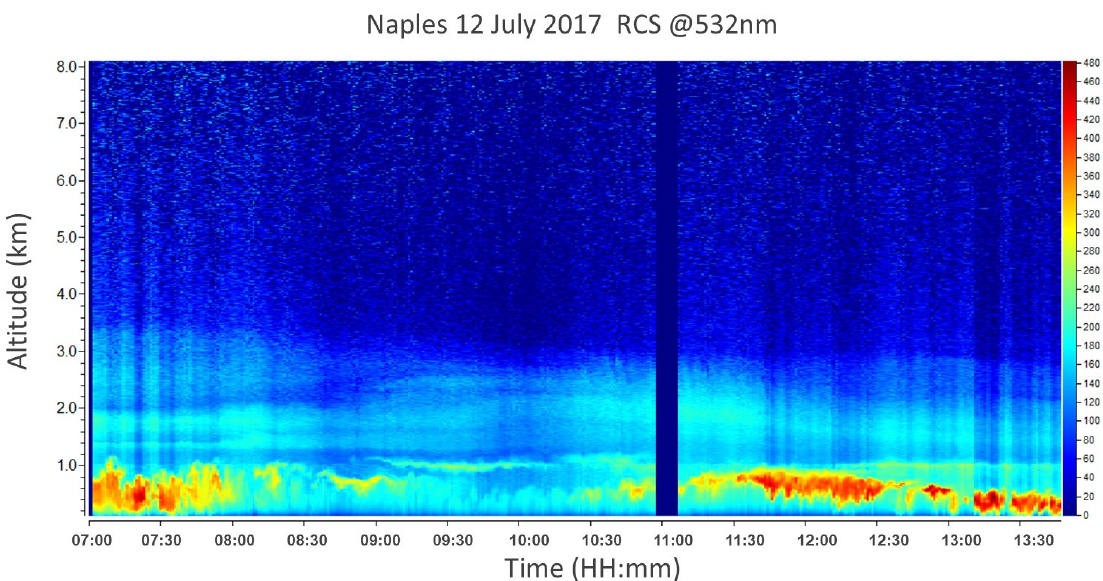
Figure 13. Time variability of the RCS lidar signal at 532 nm retrieved on 12 July 2017 from 07:00 to 13:48 UTC, with a spatial resolution of 15 m and a temporal resolution of 60 s.